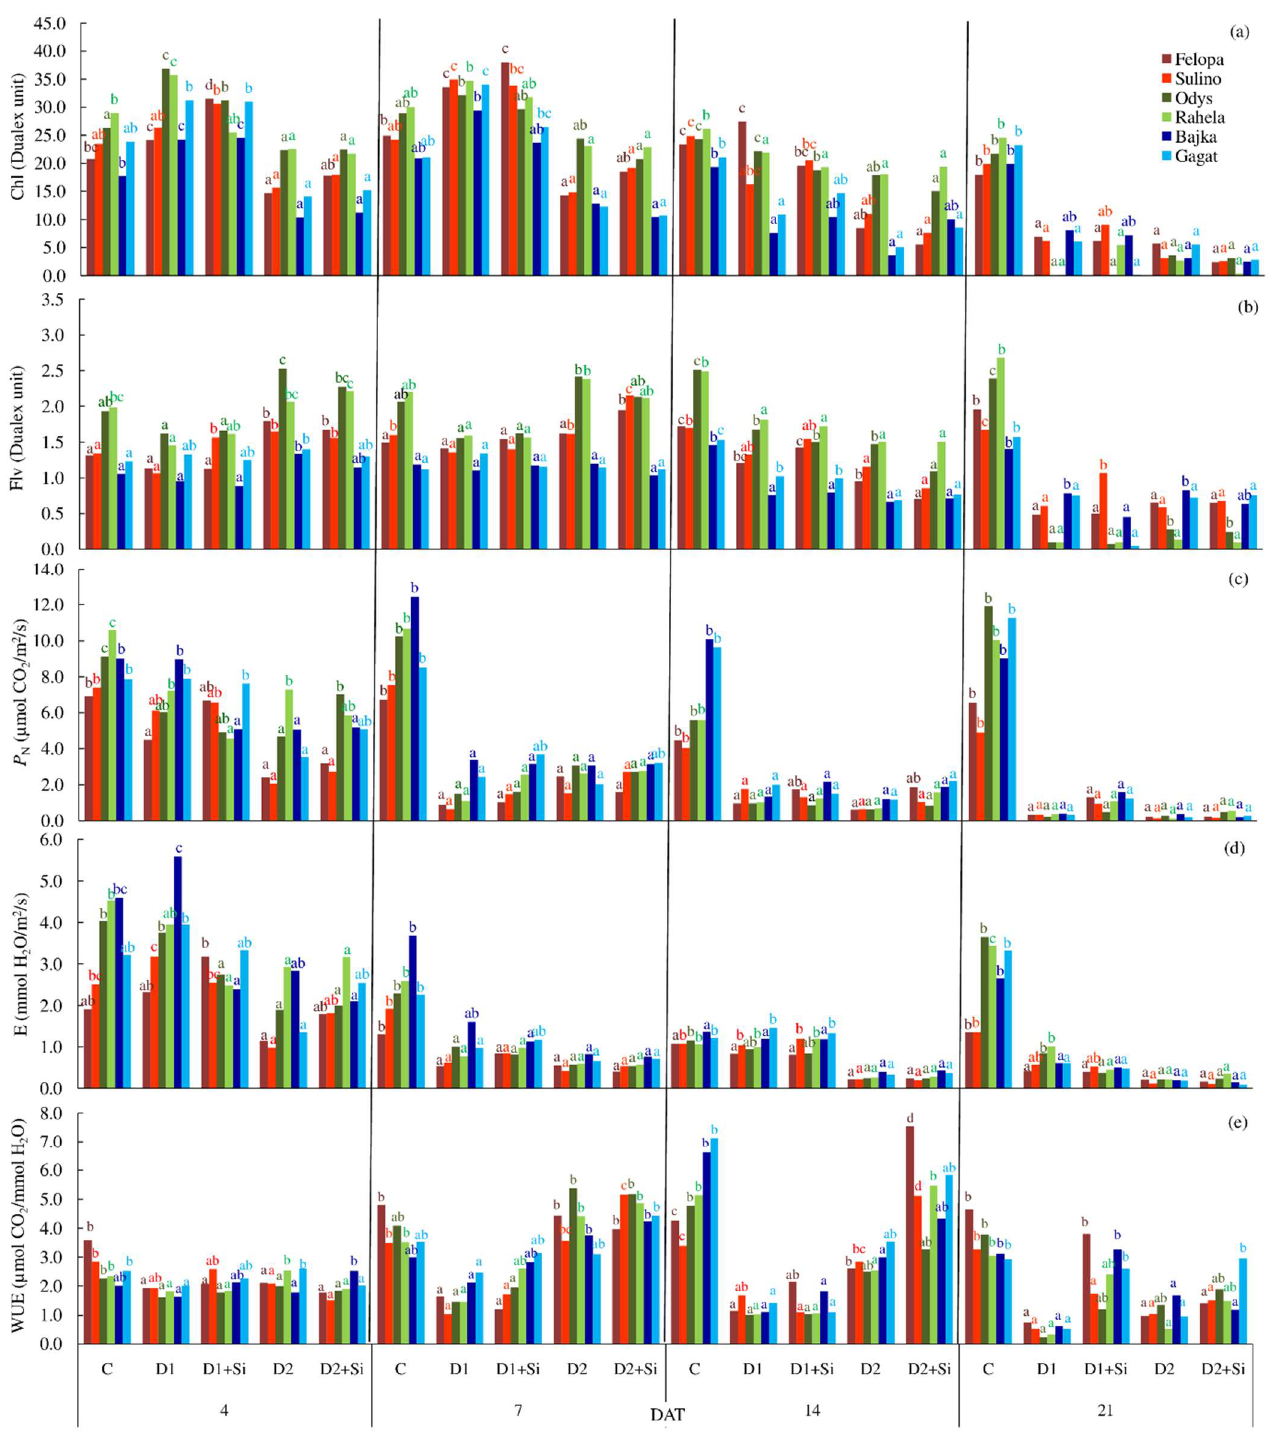
Figure 2. Variations in ( a ) content of chlorophyll (Chl), ( b ) content of flavonols (Flv), ( c ) net photo- synthetic rate ( P N ), ( d ) transpiration rate ( E ), and ( e ) water use efficiency (WUE) between cultivars of F. braunii (cvs. of Felopa and Sulino), F. arundinacea (cvs. of Odys and Rahela), and L. perenne (cvs. of Bajka and Gagat) in terms of measurement (4, 7, 14, or 21 days after treatment) depending on water conditions and terms of silicon application (C—control, D1—spring drought, D1 + Si—spring drought with Si application, D2—summer drought, and D2 + Si—summer drought with Si application); the means (bars with the same color) marked with the same lower-case letters (the same color) do not differ significantly according to Tukey’s test ( p ≤ 0.05).